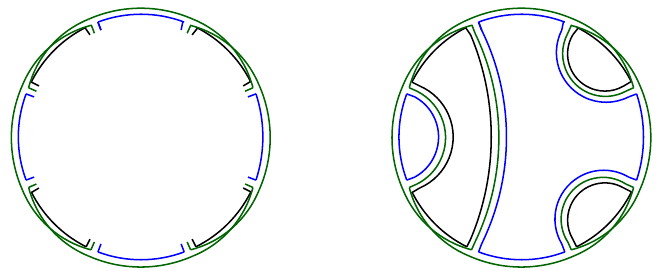
Figure 31 . One-tensor network diagrams for the negativity between the two parts of the